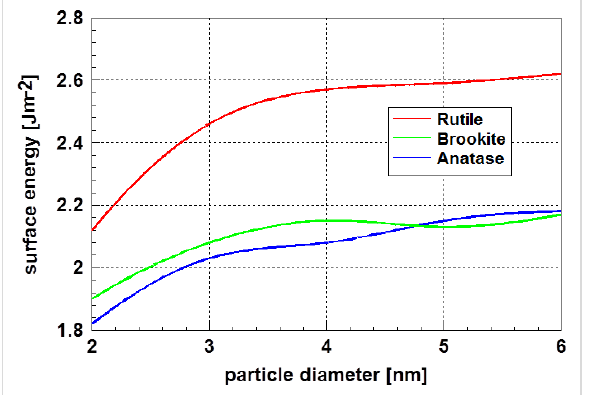
Figure 15: Surface energy of the three modifications of titania at a temperature of 300 K as function of the particle diameter according to Naicker et al. [57]. The reduction of the surface energy with decreas- ing particle diameter is remarkable. Adapted with permission from [57], copyright 2005 by America Chemical Society.